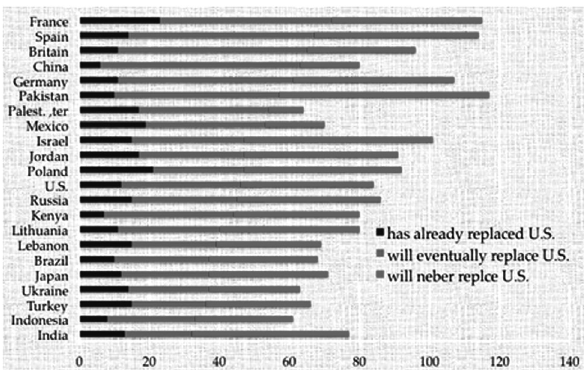
Figure 1. Will China replace U.S. as world’s leading